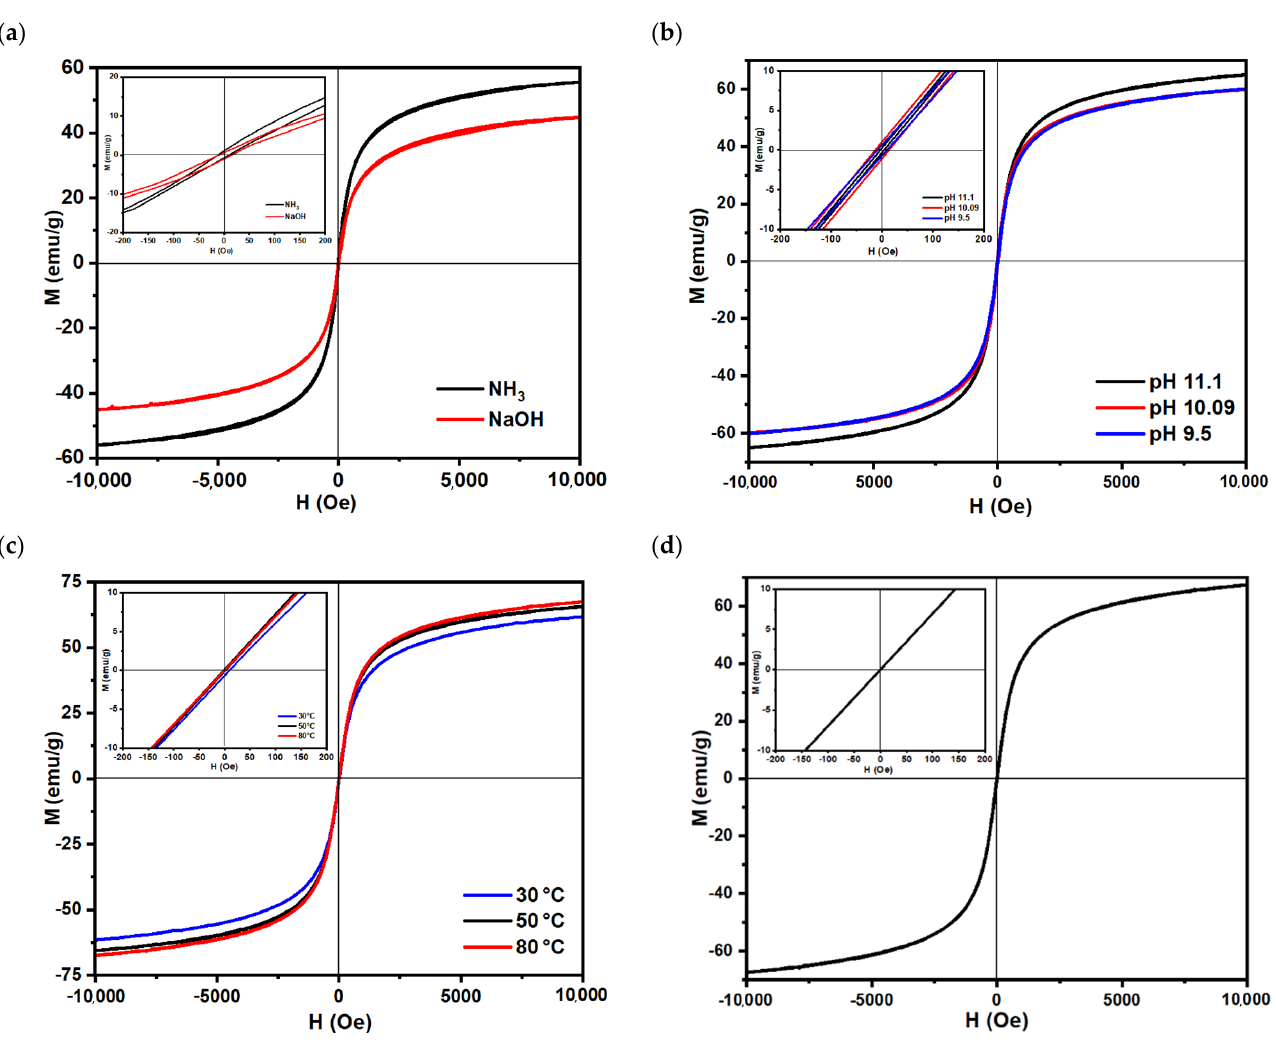
Figure 1. Magnetization changes in function of an amplitude of the magnetic field for ( a ) different co-precipitation agents: NH 3 and NaOH, ( b ) different pH: 9.5; 10.09; 11.1, ( c ) different temperature during synthesis 30 °C, 50 °C, and 80 °C, and ( d ) optimized conditions.